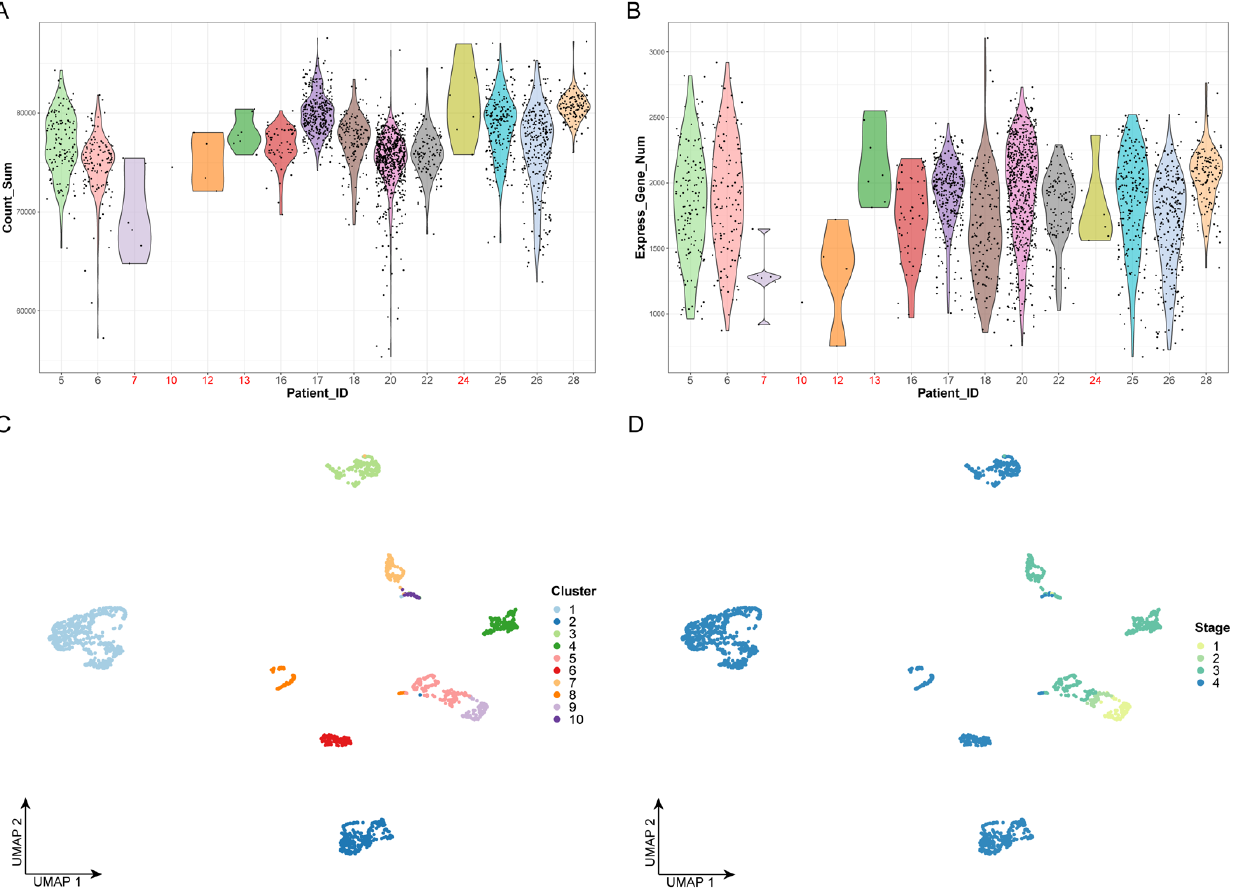
Figure 1. Data preprocessing and unsupervised clustering: ( A ) Violin plot of gene expression counts. The x -axis represents the patient ID, while the y -axis represents the sum values of gene expression counts. The dots represent the cells. Patient IDs that failed quality control are marked in red. ( B ) Violin plot of expressed gene numbers. The x -axis represents the patient ID, while the y -axis represents the number of expressed genes. The dots represent the cells. Patient IDs that failed quality control are marked in red. ( C , D ) The results of cell clustering. The dots represent the cells. The x - and y -axes represent the two dimensionalities of UMAP, respectively. Cells are colored by cluster label in panel C and by clinical stage in panel D.